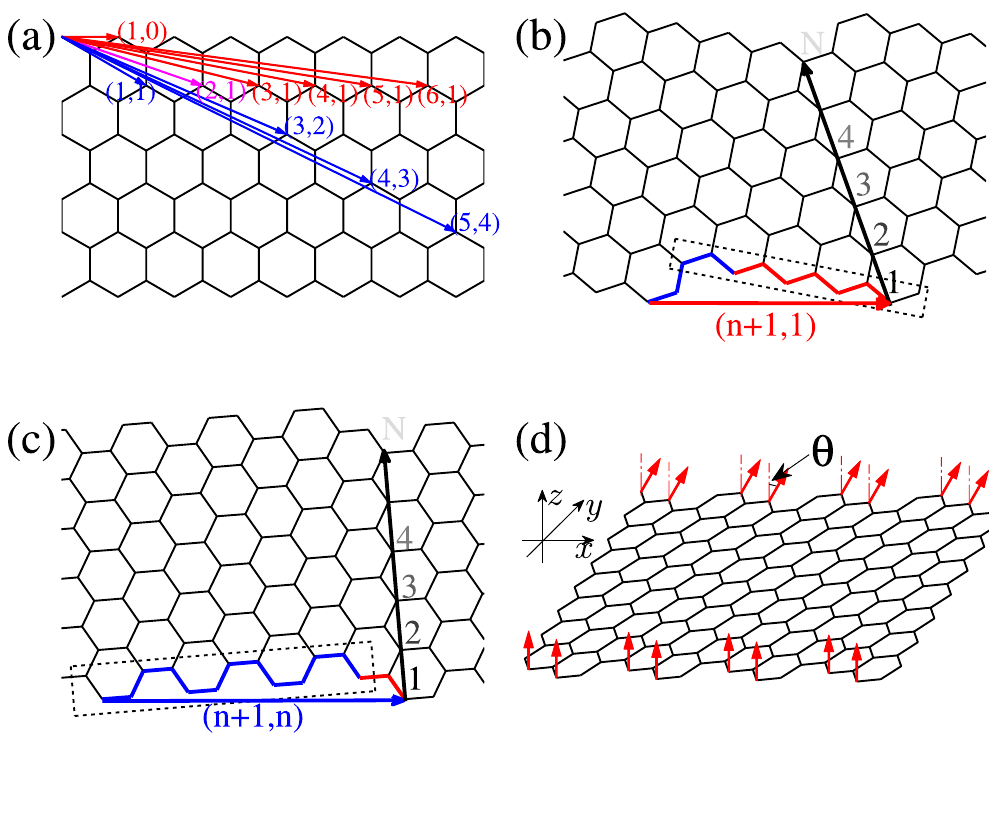
Figure 1. ( a ) The chiral orientations and corresponding indices ( n , m ). ( b ) Zigzag-like chiral ribbons with indices ( n + 1,1). ( c ) Armchair-like chiral ribbons with indices ( n + 1, n ). ( d ) Nonlocal transistor controlled by the edge magnetization based on chiral ribbon